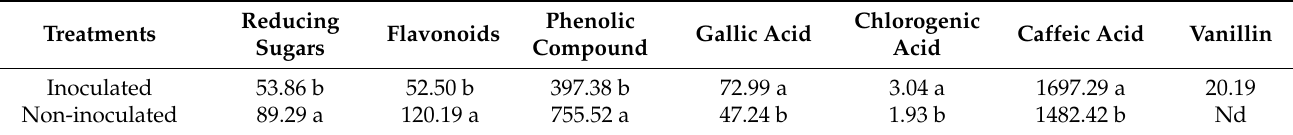
Table 2. Contents of reducing sugars (mg glucose g − 1 extract), flavonoids (mg Q g − 1 extract), total phenolic compounds (mg GA g − 1 extract), gallic acid (mg 100 g − 1 ), chlorogenic acid and caffeic acid (mg 100 g − 1 ) in extracts of Iapar-59 coffee leaves inoculated and non-inoculated with P. syringae pv. garcae .